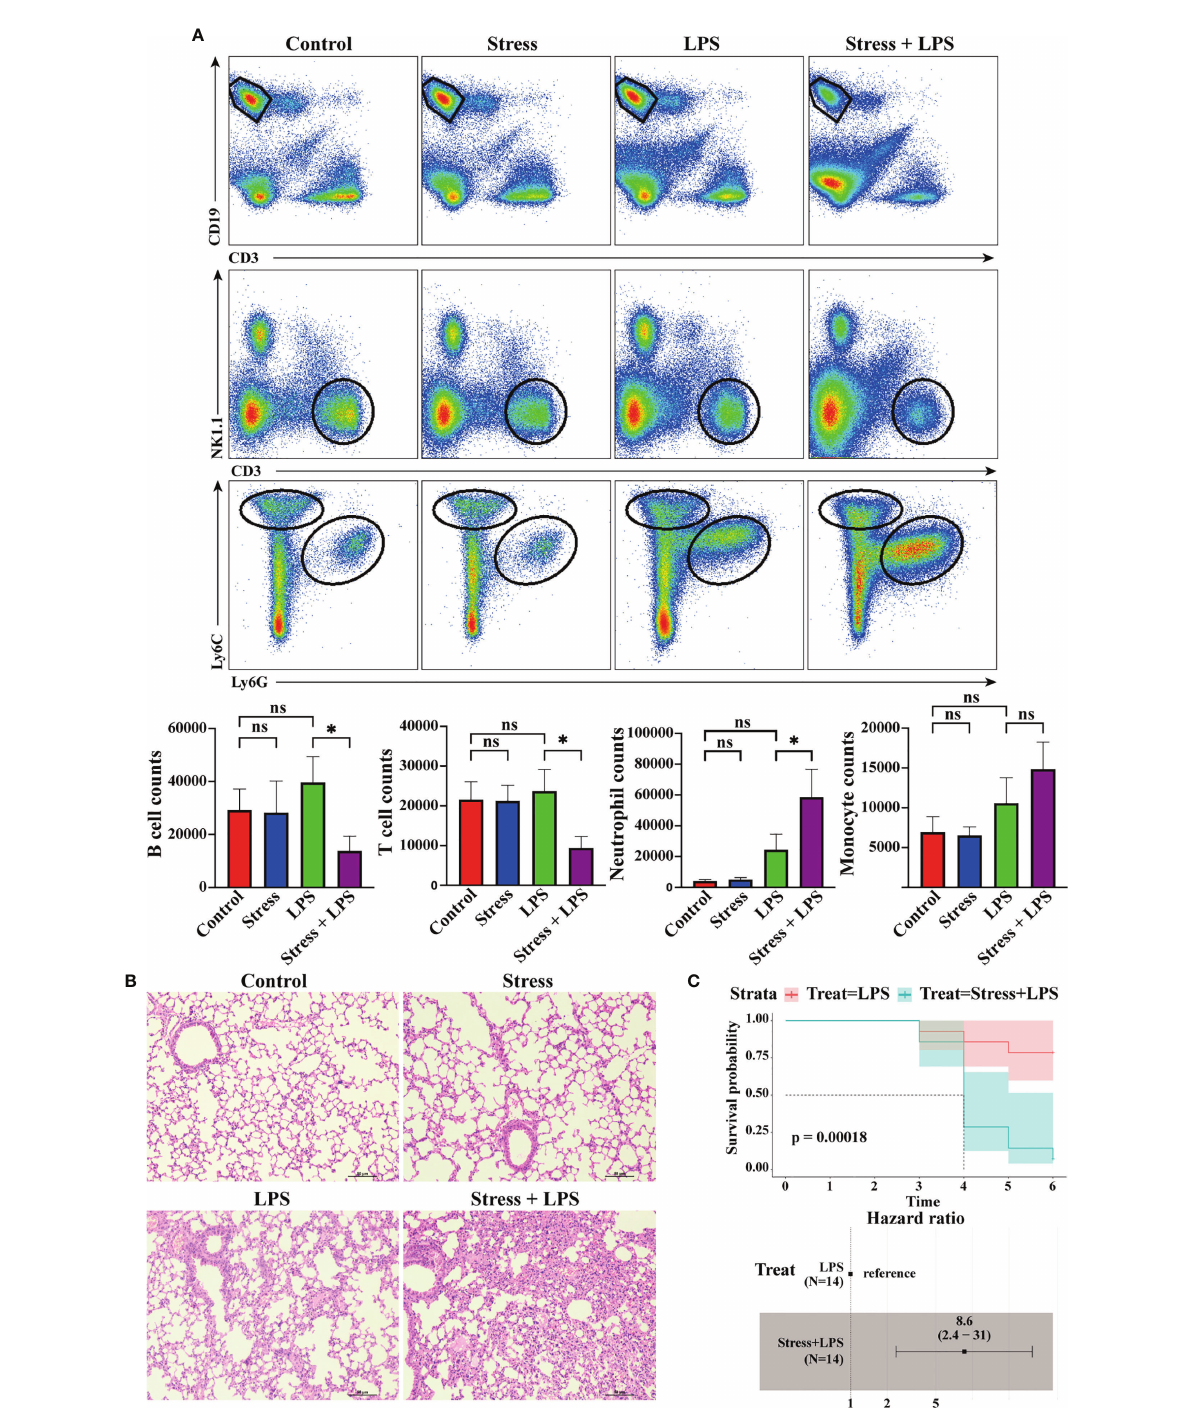
FIGURE 6 Acute stress caused excessive lung in fl ammation in LPS-treated mice. Mice were intraperitoneally injected with LPS after 6 hours of restraint stress or no stress. (A) 48 hours later, the in fl ammatory cells in fi ltrated in the lungs were detected by fl ow cytometry (n=4, per group). Histograms represent the cell number counted by fl ow cytometry. (B) Meanwhile, lungs were sectioned and stained with H&E to observe the pathological changes. (C) Mice received LPS stimulation with or without restraint stress every day, and the mortality and hazard ratio were calculated (n=4, per group). *P < 0.05, Means ± SD are shown. Data are representative of 3 independent experiments. ns, no signi fi